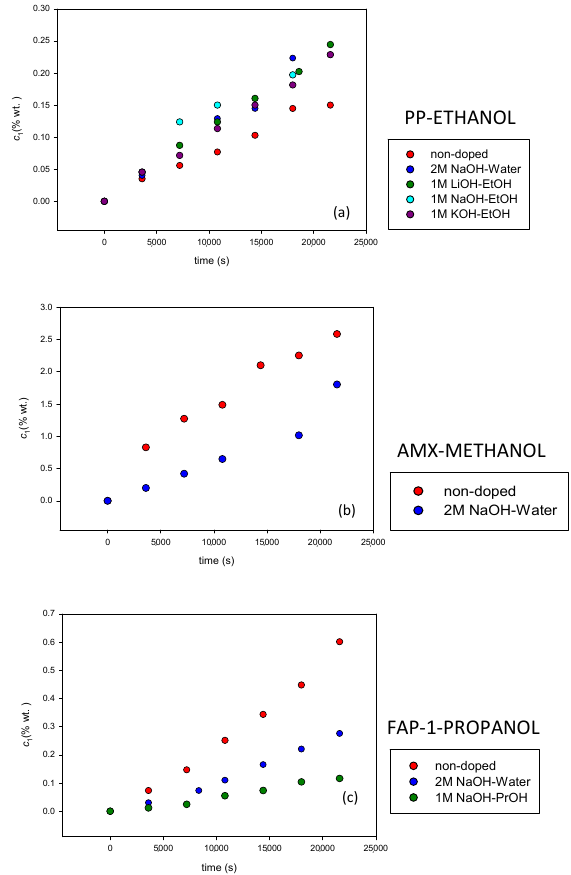
Figure 3. Concentration as a function of time for different membrane systems. ( a ) Heterogeneous PP membrane with ethanol doped with different doping agent in ethanol media. ( b ) Homogeneous AMX membrane with methanol. ( c ) Homogeneous FAP membrane with different doping agent in 1 ‐ propanol media.